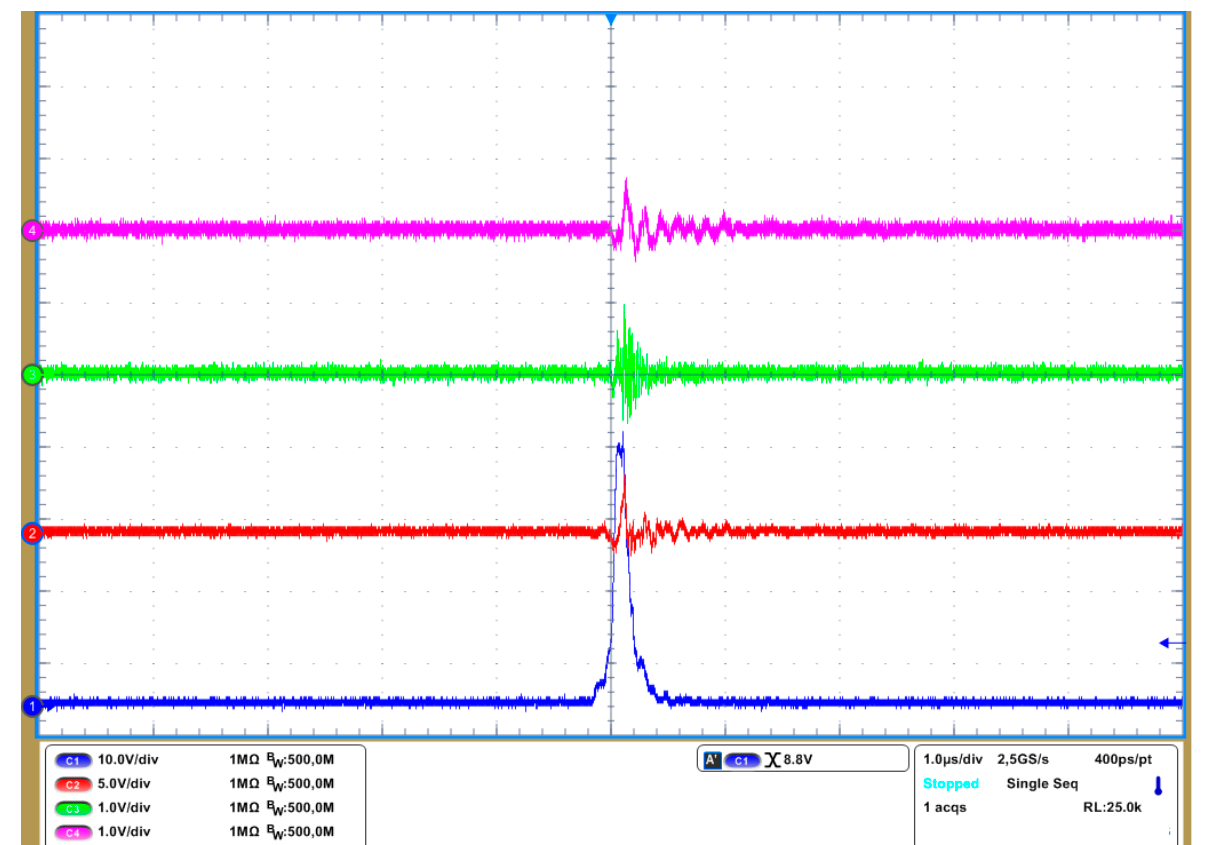
Figure 4. Characteristic oscillogram of the main stage discharge current pulse (blue signal) between a single artificial positively charged thundercloud cell and the ground involving one group of model hydrometeors and signals, registered by antennas A1–A3 (red, green and magenta signals resp.). The parameters of the first and repeated (if any) current pulses for the main stage of discharge from the positive polarity ATC with the participation of one group of model hydrom-